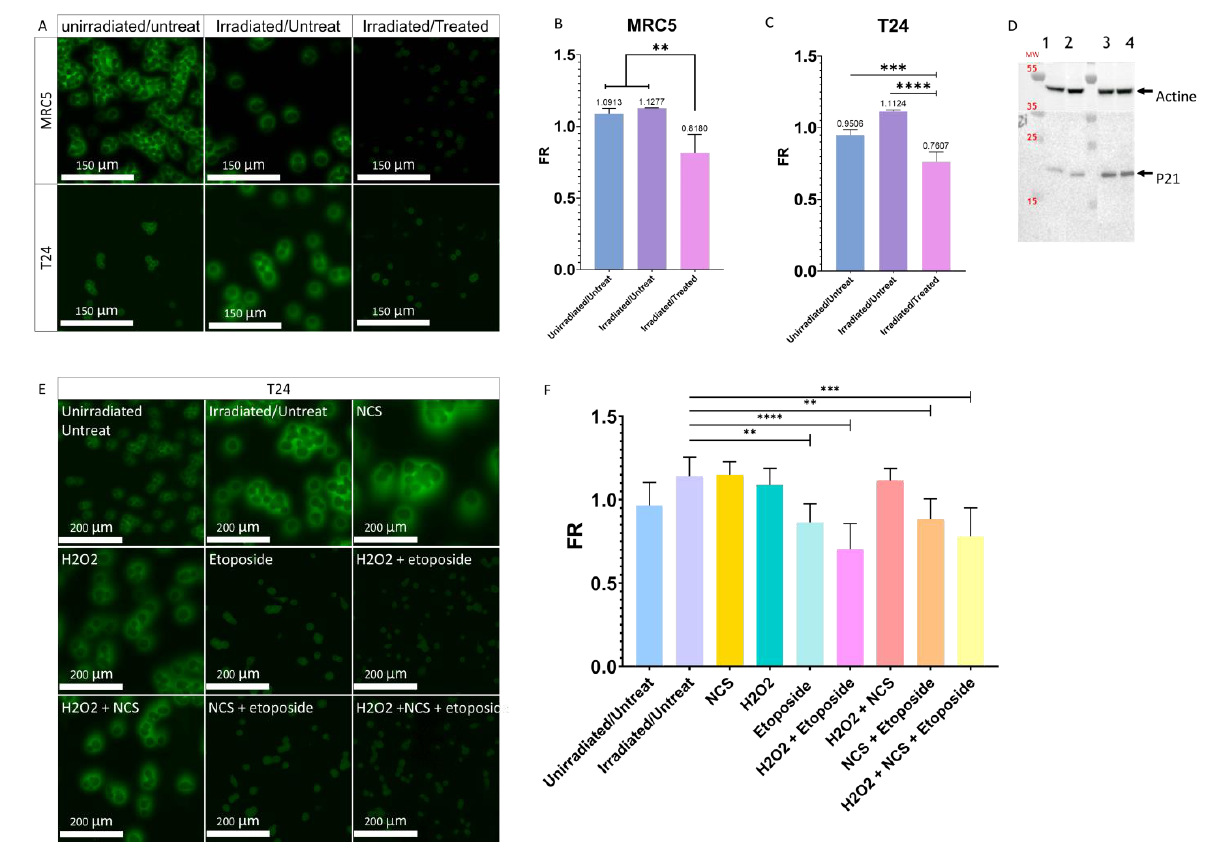
Figure 5. Involvement of cellular stress in the modulation of PMF. ( A ) Effect of irradiation with or without treatment on the PMF of MRC-5hTERT and T24 cells after nine days. ( B ) Quantitative determination of the effects of irradiation with or without treatment on the PMF of MRC-5 hTERT after nine days. Bar graphs represent the mean (SD) (** p < 0.01). ( C ) Quantitative determination of the effects of irradiation with or without treatment on the PMF of T24 cells after nine days. Bar graphs represent the mean (SD) (*** p < 0.001); **** p < 0.0001). ( D ) Western blot of P21; 1: Unirradiated/Untreated T24 cells grown with serum, 2: Unirradiated/Untreated T24 cells grown without serum, 3: Irradiated/Untreated T24 cells grown without serum, 4: Irradiated/Treated T24 cells grown without serum. The original blots could be found in the Figure S9. ( E ) Effect of the different treatments and molecules to induce senescence and cellular stress on the T24 cell PMF after nine days. ( F ) Quantitative determination of the impact of different treatments and molecules to induce senescence and cellular stress on T24 cell PMF after nine days. Bar graphs represent the mean (SD) (** p < 0.01; *** p < 0.001); **** p <